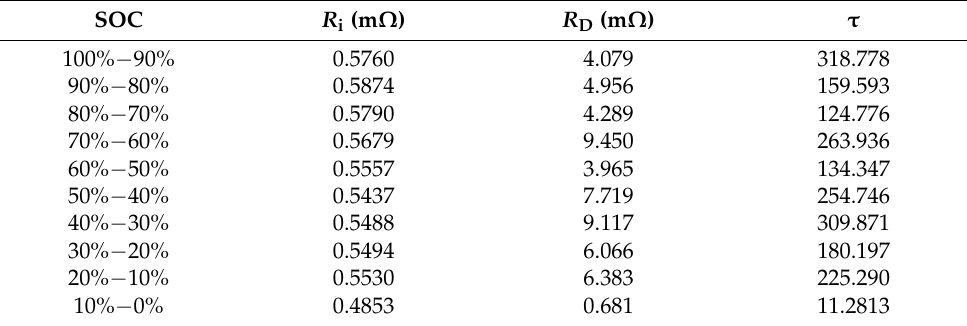
Table 2. Parameter identification results of Thevenin model for supercapacitors.